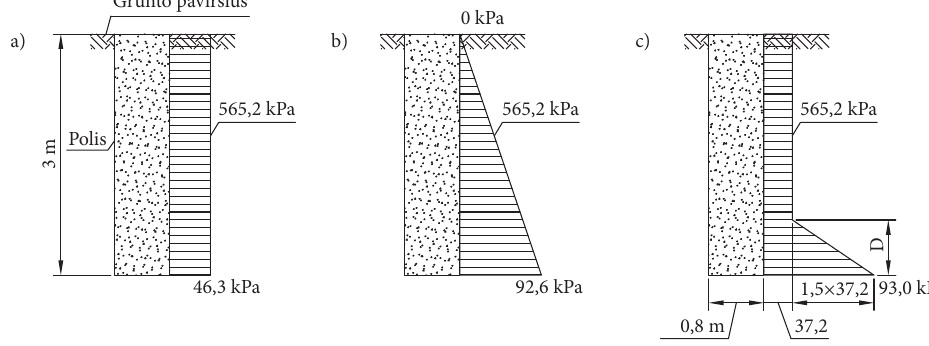
Fig. 1. Dippendence of variable soil stiff ness across the